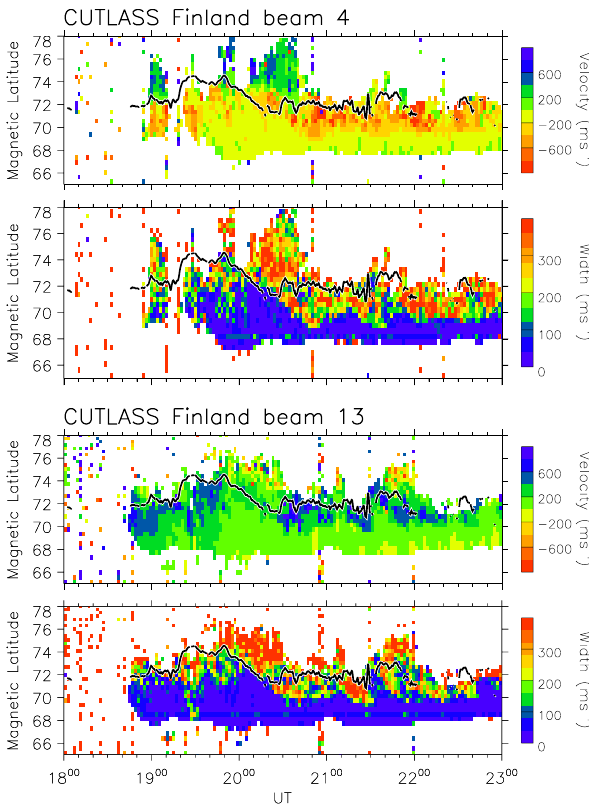
Fig. 5. Line of sight velocity and spectral width for beam 4 (top two panels) and beam 13 (bottom two panels) for the same interval as Fig. 4. The full line marked on each panel of the radar data represents the poleward 1.5 kR contour of the 630.0 nm emission (see text for full